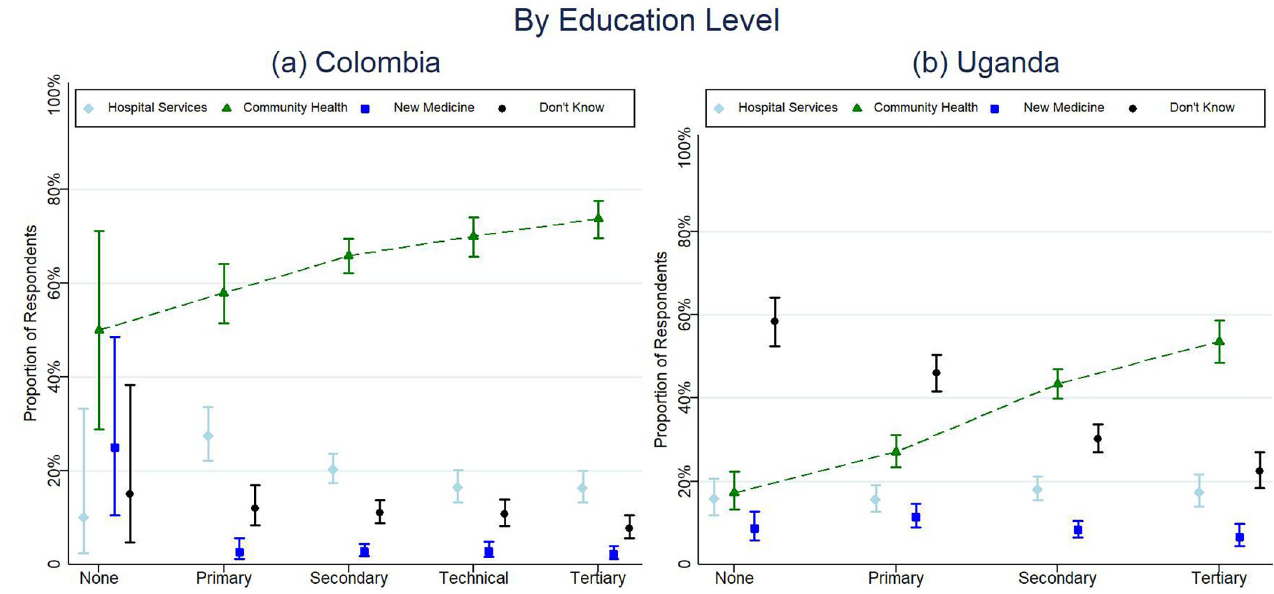
Fig 4. Understanding by participant’s education in Colombia and